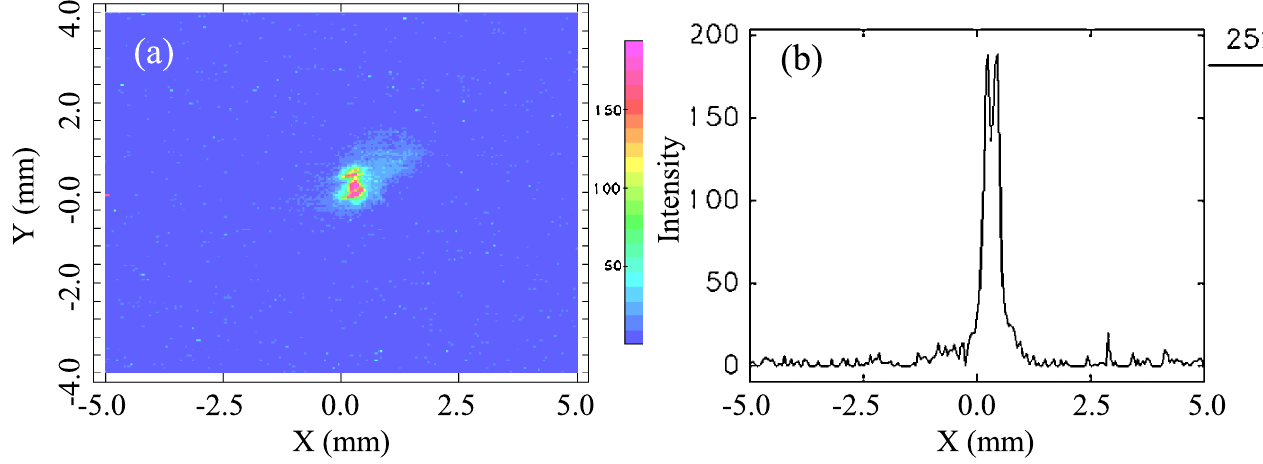
FIG. 5. (Color) OTR beam image (a) and horizontal profile (b) through spike in distribution after the chicane with L2 phase ¼ 14 : 9 degrees , close to maximum compression [11].